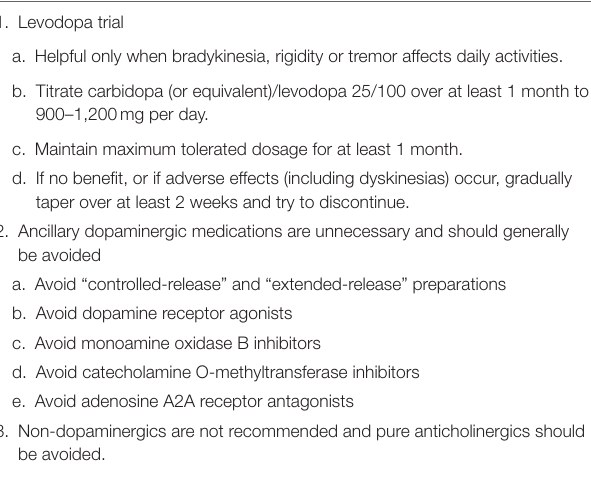
TABLE 1 | Management of motor Parkinsonism in